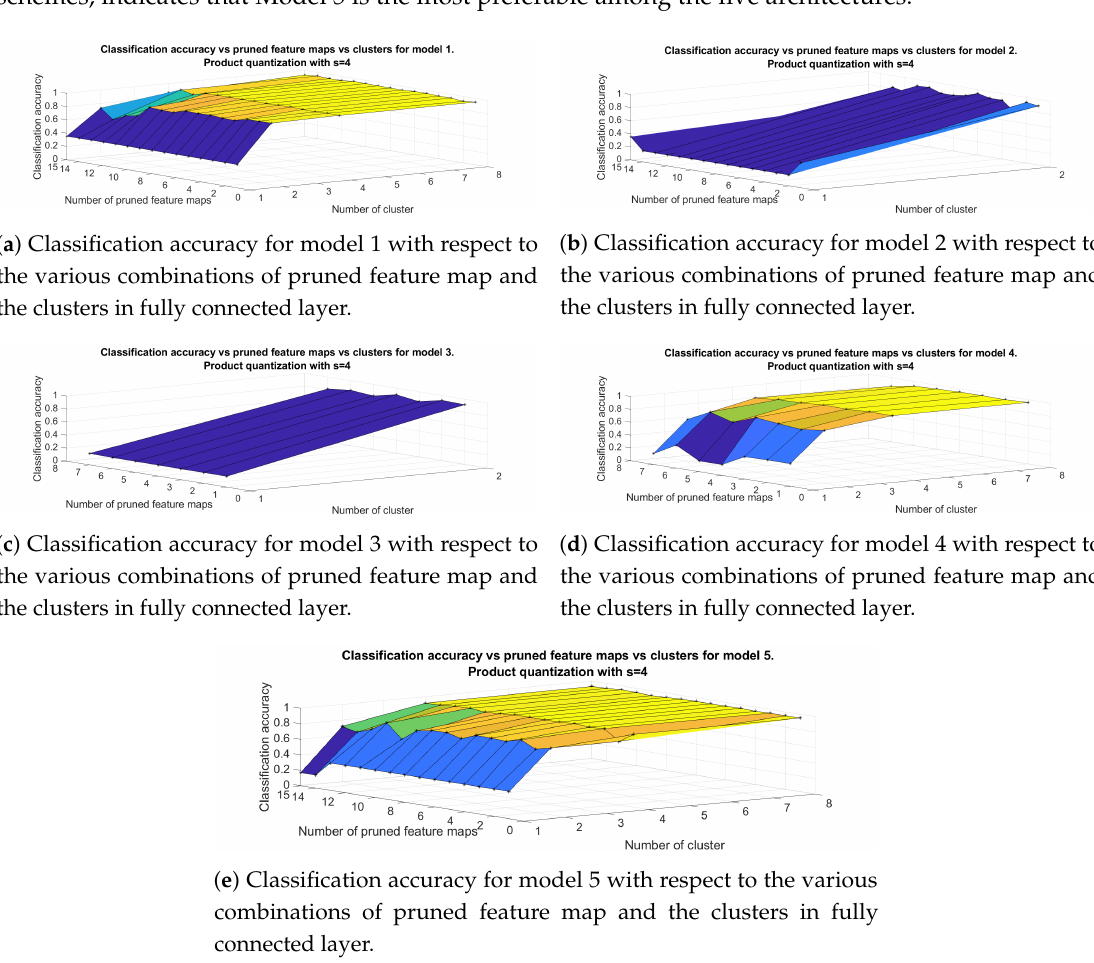
Figure 10. Classification accuracy for models in Table 1 for the approach that include filter pruning and product quantization with s = 4. Table 13. Number of clusters and pruned filters for each model with a compression rate equal to